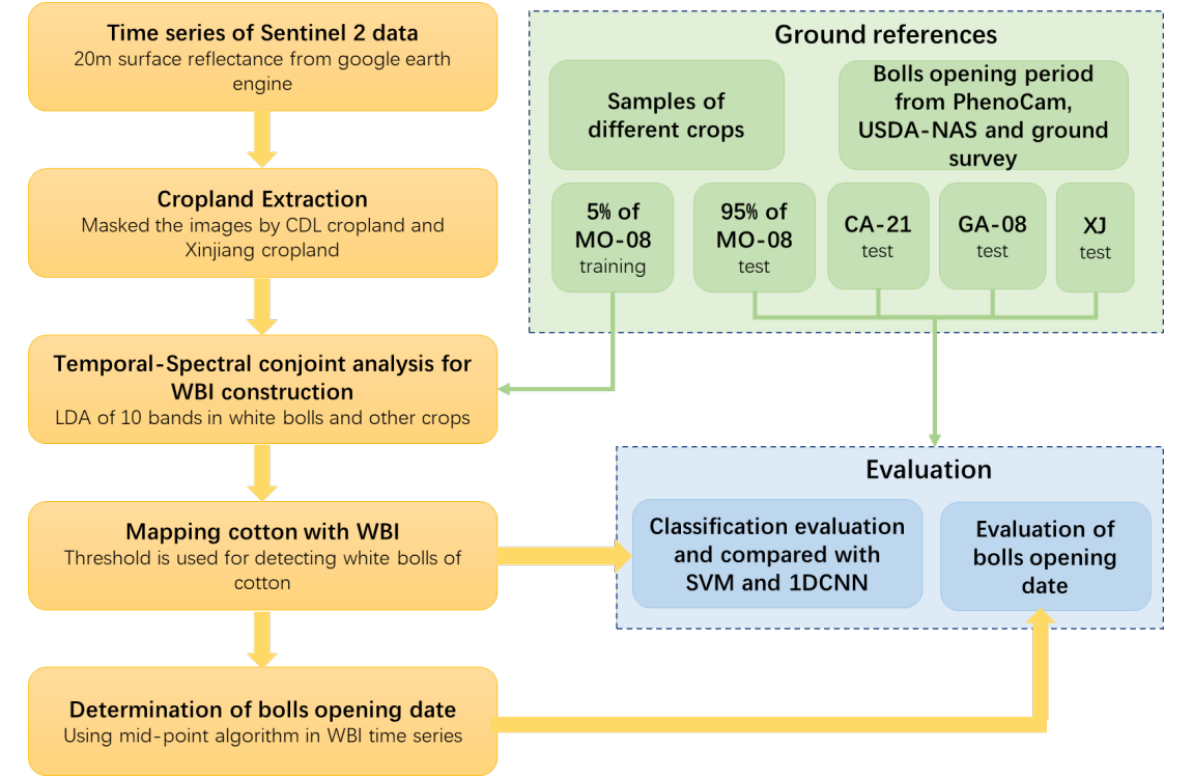
Figure 1. Flowchart of the current study for automatic mapping of cotton.